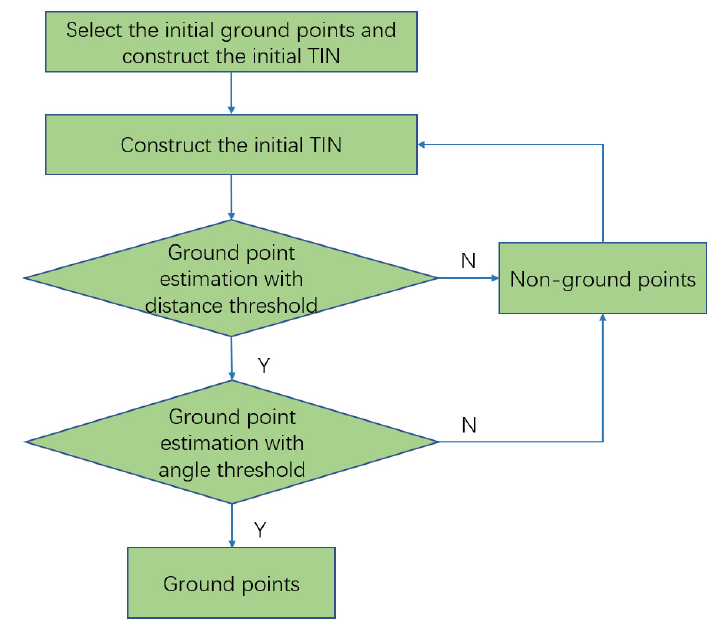
Figure 3. The iteration processing of the ground points generation.